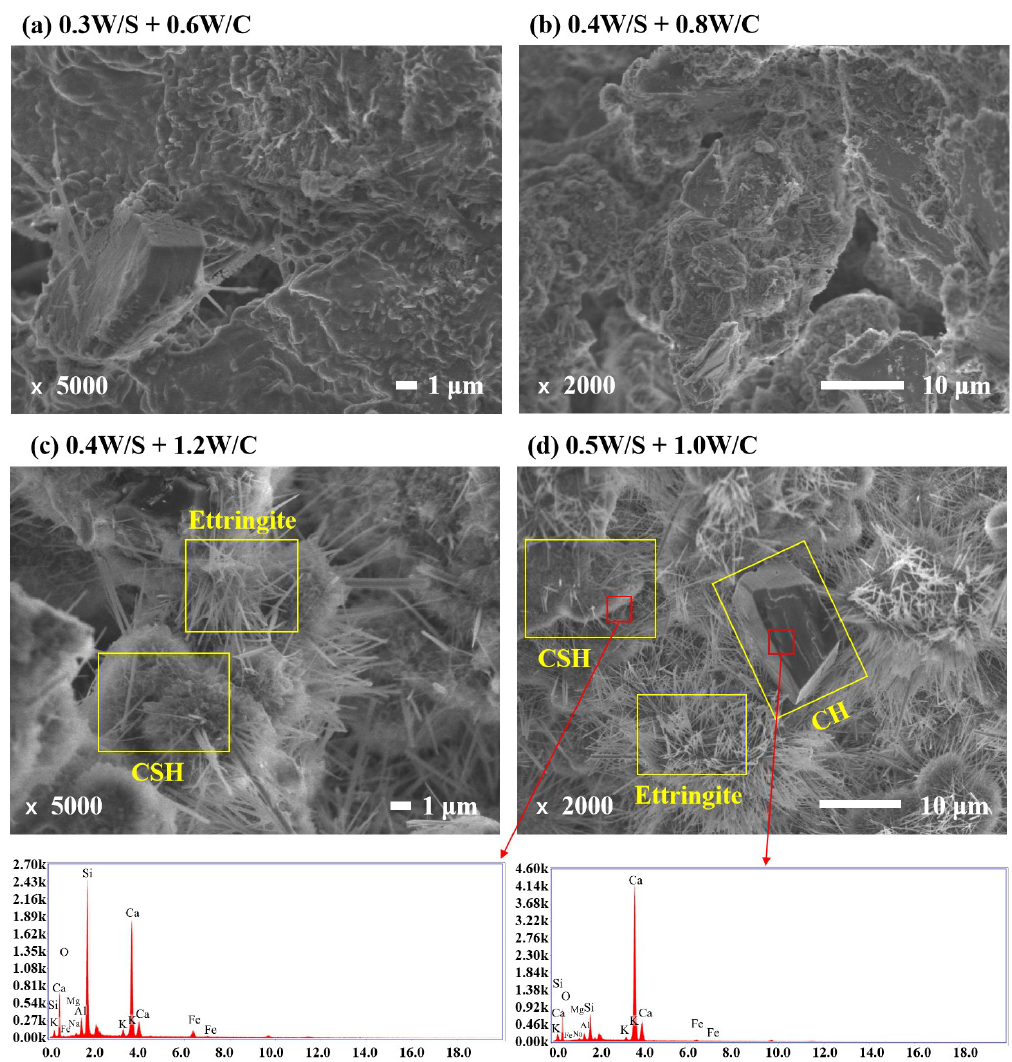
Figure 6. Microstructural features of CPB specimens at 28 d.